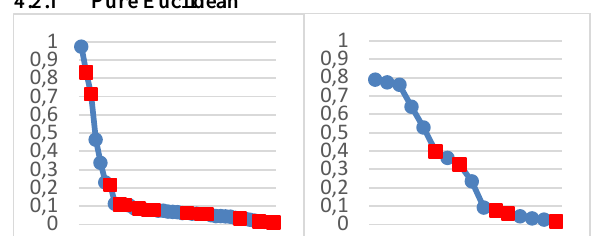
Figure 2: Pure Euclidean Scores for a simple (left, Moosach) and a complex (right, Munich City) region Figure 2 shows decreasing matching scores of Pure Euclidean Matching. False positives are marked as red squares. Of the 37 matching pairs defined by the ground truth matching for the Moosach sample, 26 (70%) were correctly identified. There were 15 false positives and 11 false negatives. The complex sample yielded slightly worse results: 11 (65%) correct matching pairs, 5 false positives, and 6 false negatives. Since false positives seem to be evenly distributed among the scores, a safe threshold for discarding bad matchings must be set at the very end of the scale.